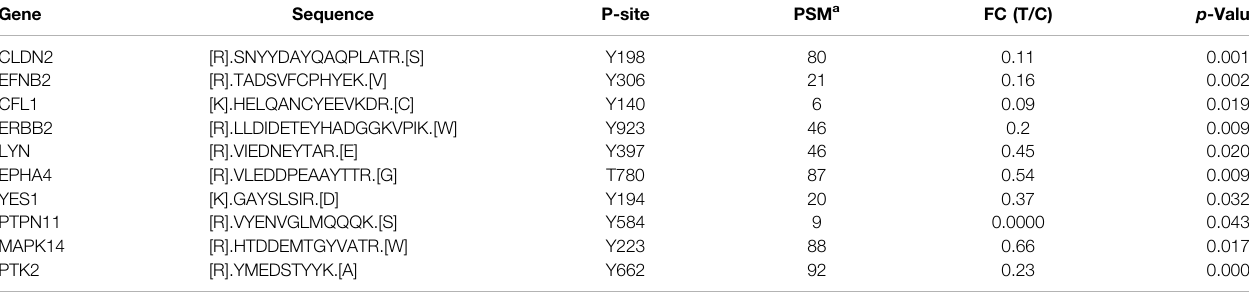
TABLE 2 | List of signi fi cantly hypo-phosphorylated proteins at tyrosine residue upon inhibition of CAMKK2 involved in cell migration.